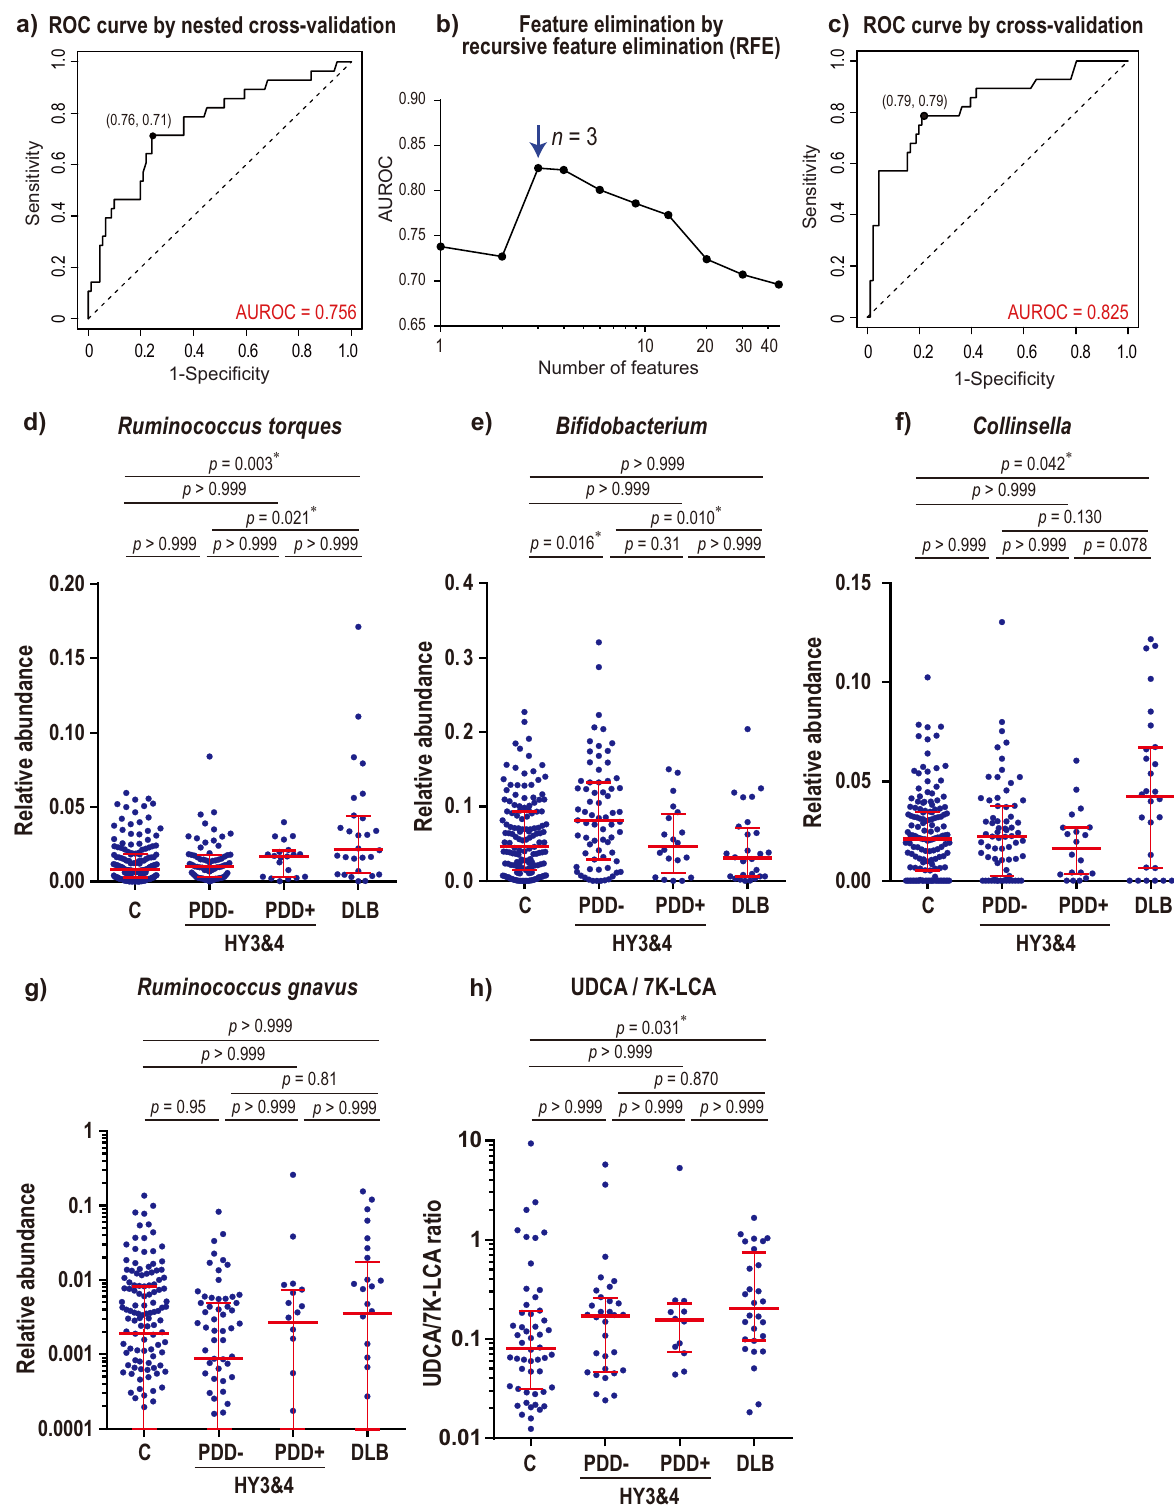
disease 44 – 47 , and ALS 48,49 , and are likely to be a shared feature in neurodegenerative diseases. SCFA, especially butyrate, amelio- rates mucosal in fl ammation and oxidative status, increases the intestinal mucin layer, and induces regulatory T cells by suppressing histone deacetylases 50 – 52 . Two of the three